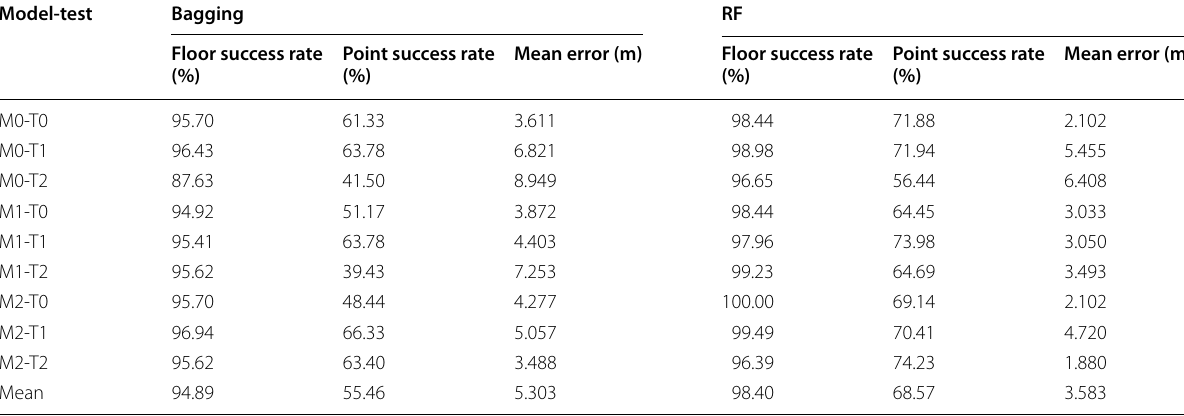
Table 7 The results of different classifiers and testing samples using Bagging